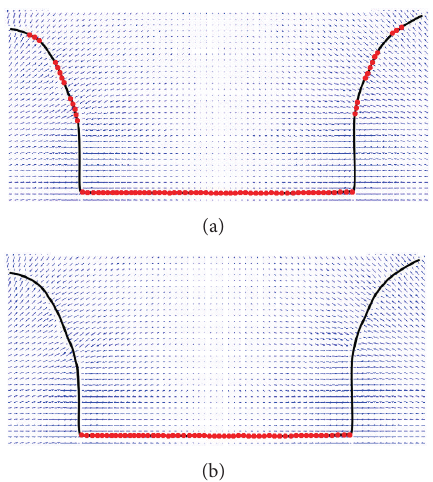
Figure 4: Judgements of false parts in active contour by [22] and our new method.